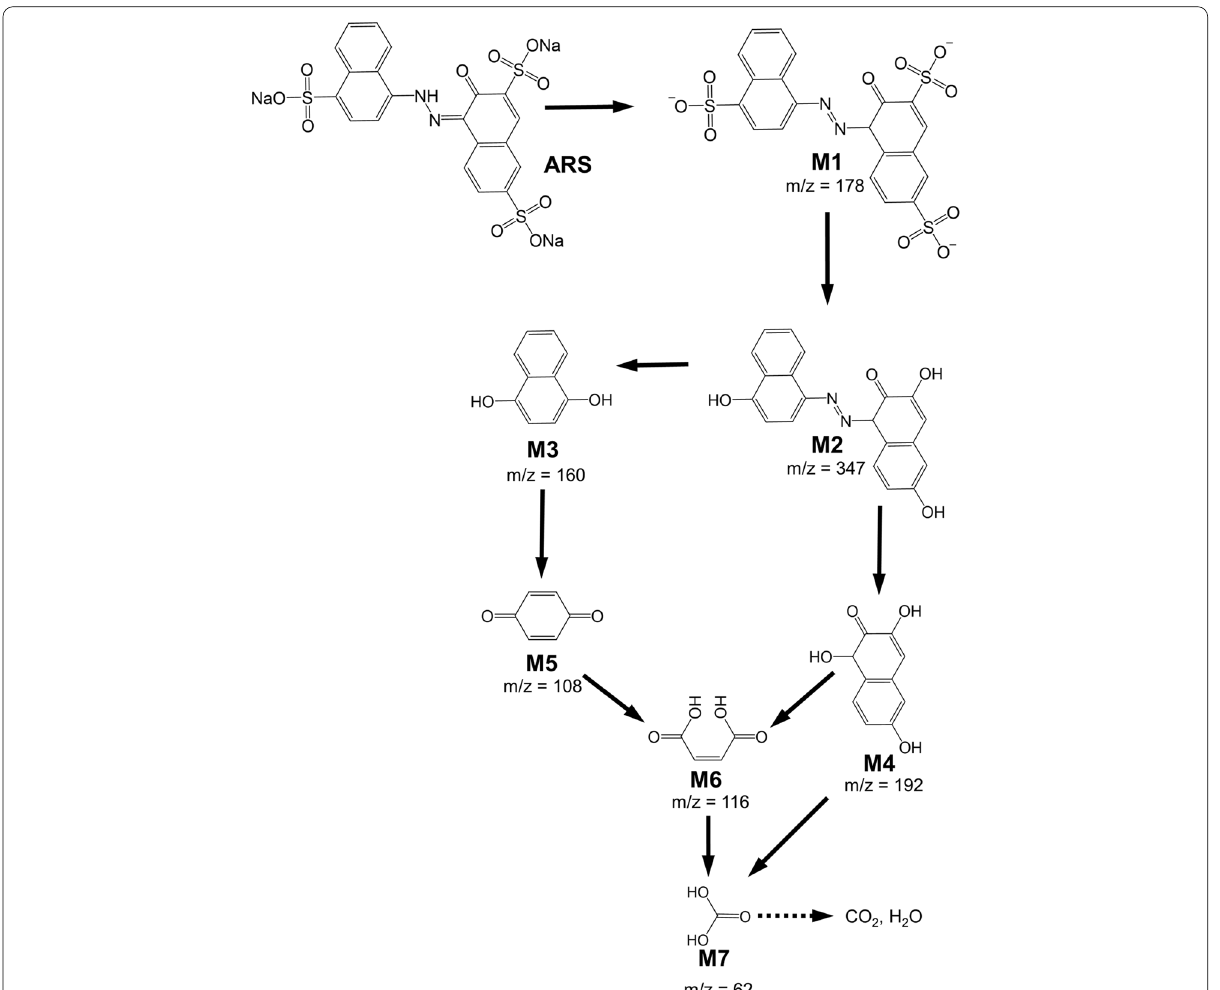
Fig. 8 A potential degradation pathway of ARS by HOCO‑activated